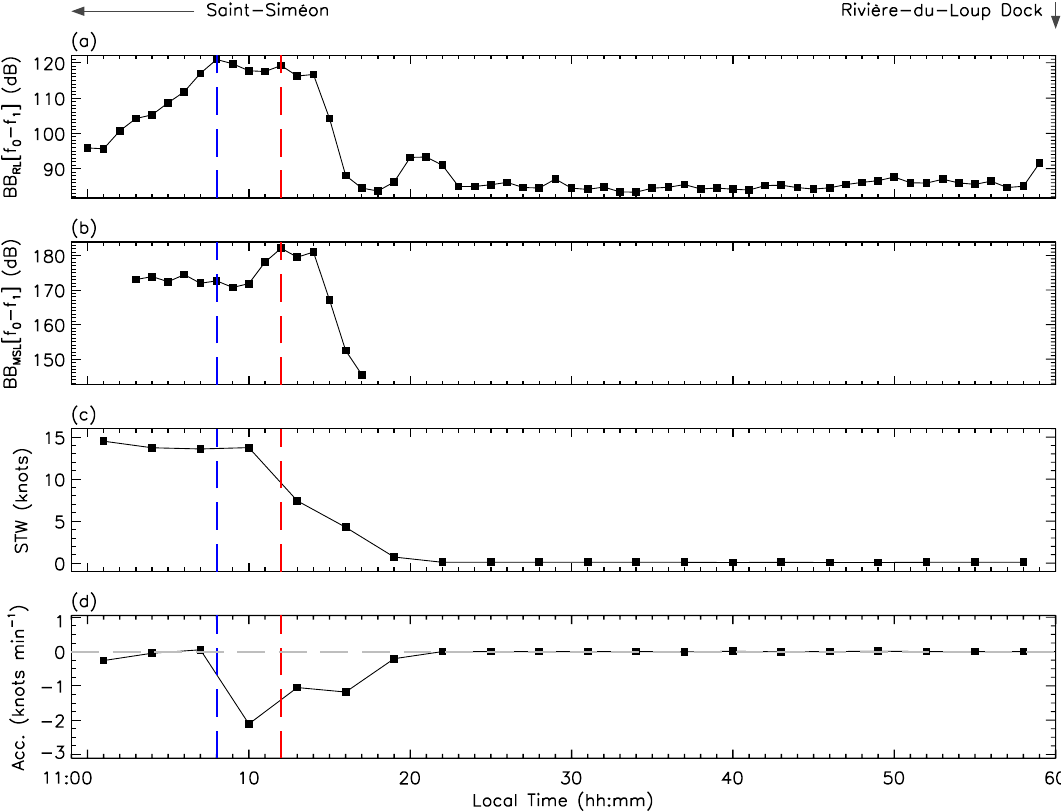
Figure 3. Same as Fig. 2 for the ferry’s arrival on 2020-07-22 11:00-to-12:00 EDT. Saint-Siméon is located on the far-left of the figure. The ferry moves from left to right towards the dock positioned on the figure’s